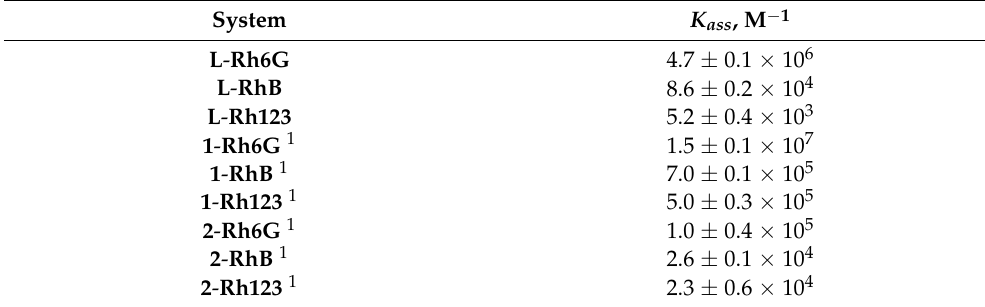
Table 1. Association constant ( K ass ) of thiacalix[4]arene L and calix[4]arene 1 , 2 complexes with